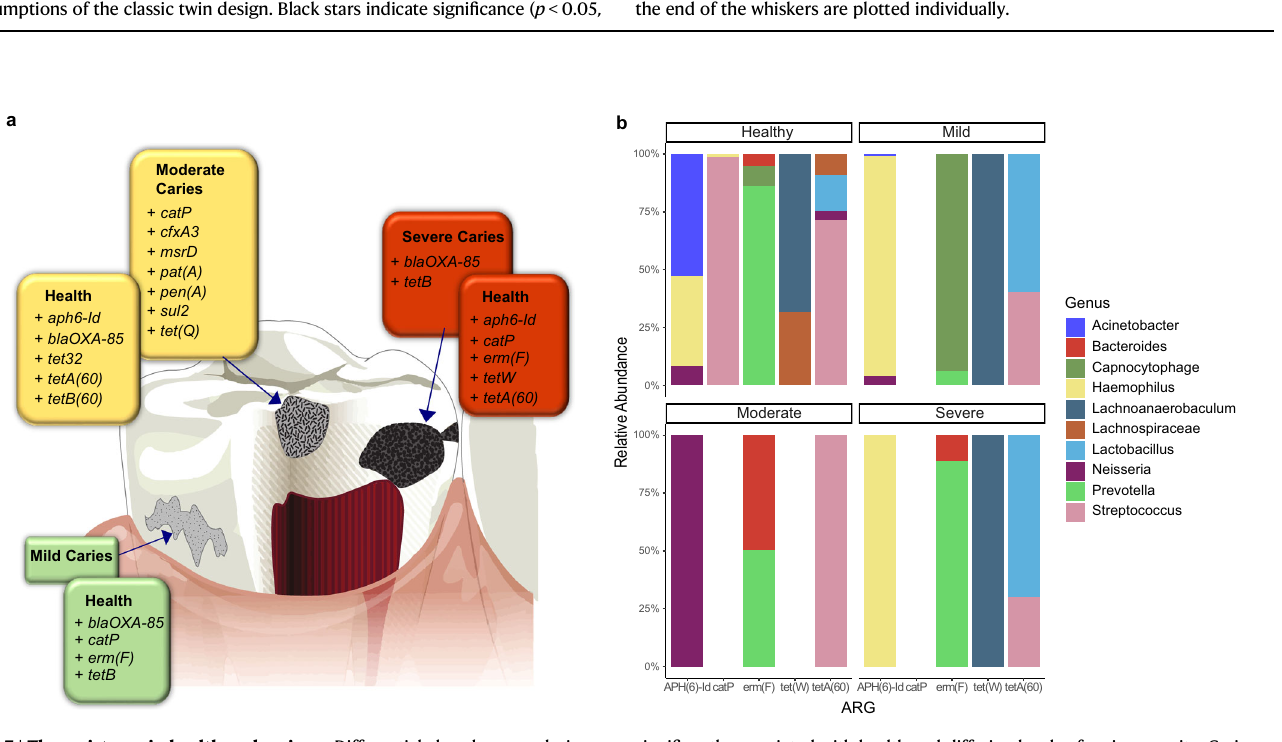
signi fi cantly associated with health and differing levels of caries severity. Caries severity was strati fi ed by ICDAS II scores (health=0, mild=1 – 2, moderate=3 – 4, severe=5 – 6). 7a is adapted from Fig. 2 Simon-Soro and Miro 2014 70 with permis- sion from Elsevier.